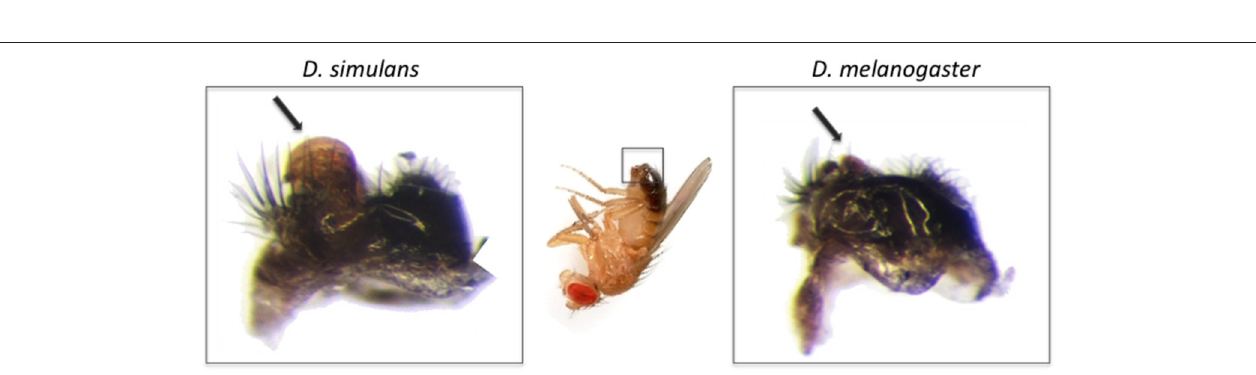
FIGURE 4 | Species confirmation using male genitalia. As described in (Ashburner et al., 2011) we show the distinctive male genital arch (arrows) of D. simulans (left) and D. melanogaster (right) .